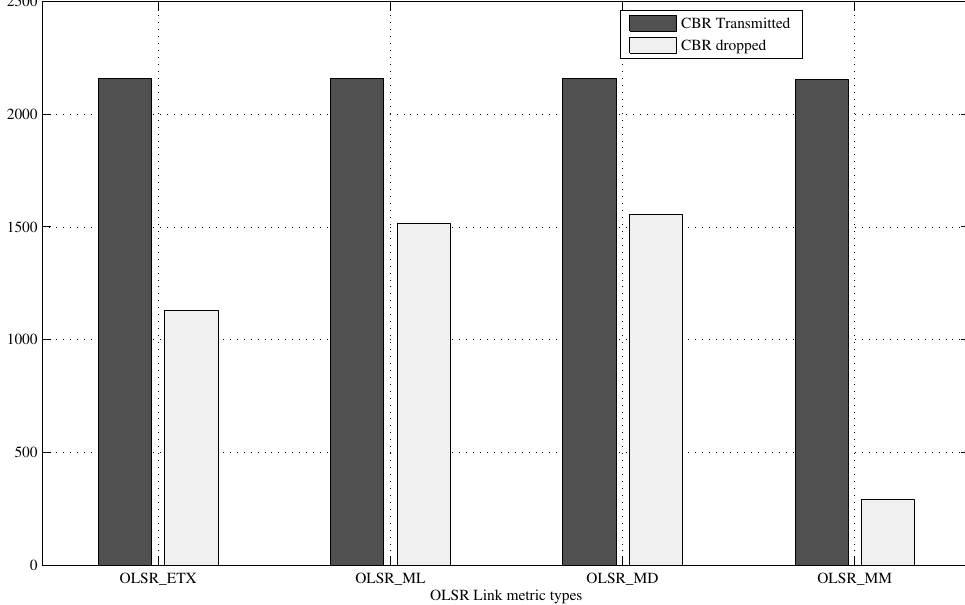
Figure 7. Transmitted and dropped CBR packets for power quality